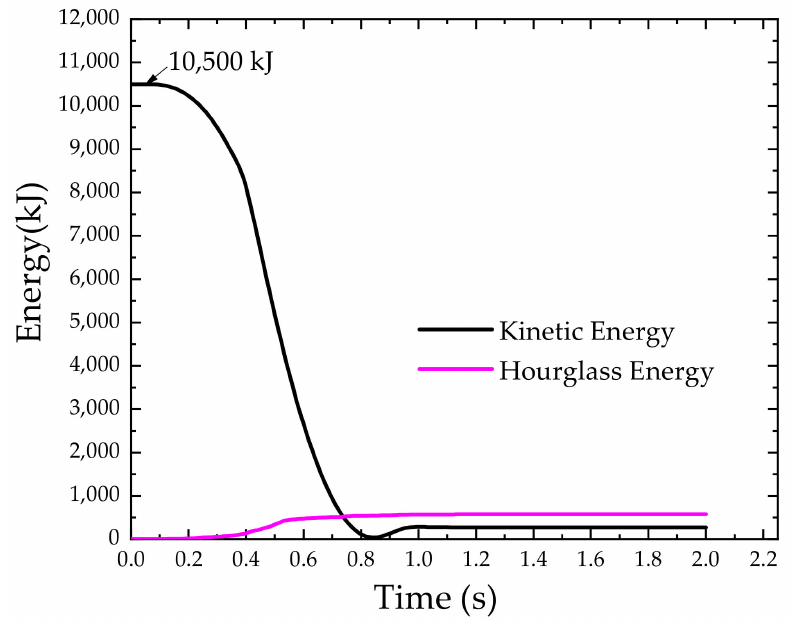
Figure 14. Energy–time curve during collision.